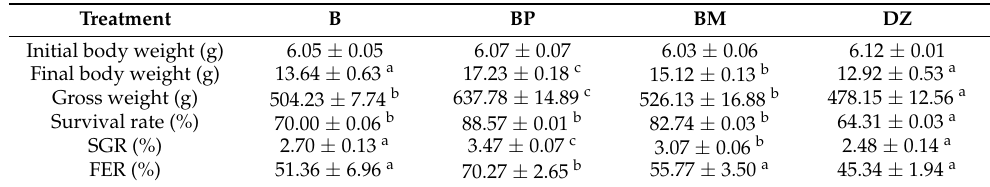
Table 1. Gross weight, survival rate, specific growth rate, and the feed efficiency rate of P. vannamei (Mean ±